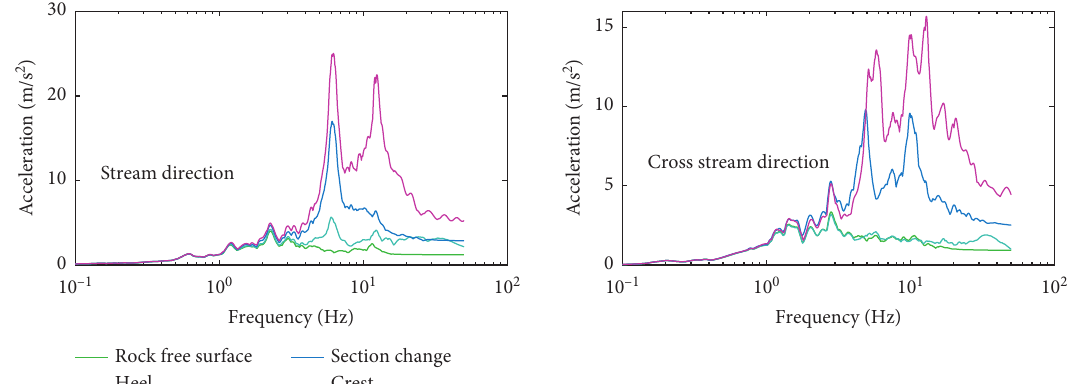
Figure 19: Response spectrum of acceleration time histories produced by Taft earthquake at the middle of heel, section change, and crest of the dam in the (a) stream and (b) cross-stream direction with rock foundation modelling using the analytical method.